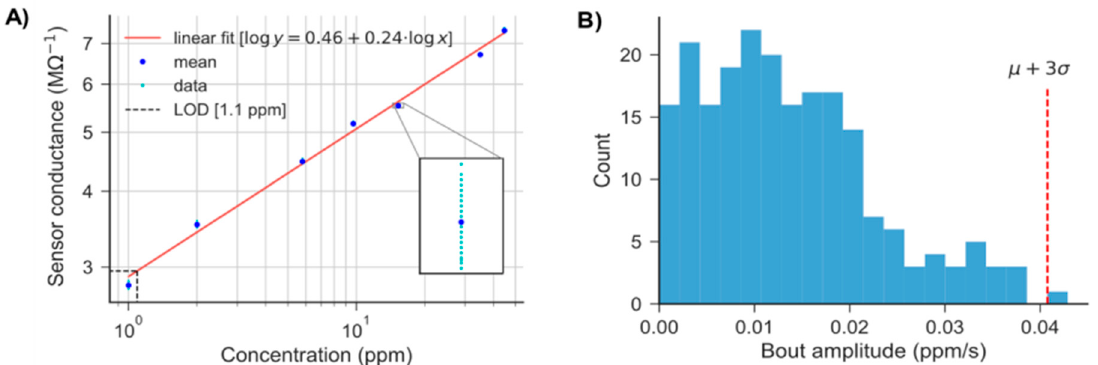
Figure 11. ( A ) Calibration line in the range 1–50 ppm (log-log plot), with blank variability superimposed at each concentration level (see inset). The LOD is estimated using Equation (2); ( B ) Histogram of amplitudes of bouts detected in the calibrated blank signals. b thr (Equation (5)) is indicated by a red dashed vertical line.